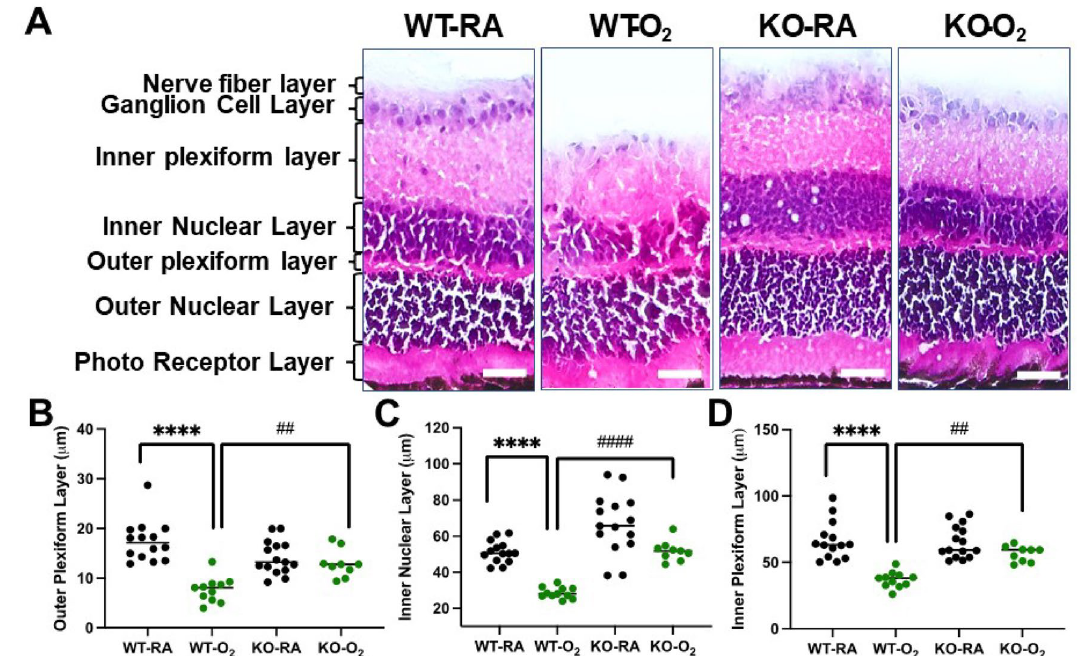
Figure 8. GSDMD-KO prevents hyperoxia-induced retinal thinning. ( A ) The thickness of the individual retinal layer was assessed on H&E stained eye sections. Hyperoxia exposure reduced the thicknesses of the outer plexiform layer, inner plexiform layer, and inner nuclear layer in WT mice. However, GSDMD-KO mice had overall decreased retinal thinning in these three layers compared to the WT hyperoxic group. ( B ) Outer plexiform layer: **** P < 0.0001, WT-RA vs WT-O 2 , ## P < 0.01, WT-O 2 vs KO-O 2. C. Inner plexiform layer: **** P < 0.0001, WT-RA vs WT-O 2 , #### P < 0.01, WT-O 2 vs KO-O 2 . ( D ) Inner nuclear layer: **** P < 0.0001, WT-RA vs WT-O 2 . ## P < 0.01, WT-O 2 vs KO-O 2. n = 9–15/group. 20 × magnification. Scale bars: 50 effects of GSDMD-KO and identify genes modulated by GSDMD-KO on hyperoxia-induced retinal injury, we performed RNA-seq of whole retinas. Principal component analysis of the retina transcriptome showed cluster- ing of hyperoxia-exposed GSDMD-KO and WT animals (Fig. 10A). To identify similarities and divergencies in genes differentially regulated by hyperoxia in the WT and GSDMD-KO animals, differential expression analysis was performed comparing RA-exposed WT vs hyperoxia-exposed WT retinas and RA-exposed GSDMD-KO vs hyperoxia-exposed GSDMD-KO retinas, and the results were analyzed at the gene expression and pathway levels (Fig. 10B). In WT retinas hyperoxia differentially regulated 1224 genes, and in GSDMD-KO retinas, hyperoxia differentially regulated 1360 genes. There were 480 genes commonly induced or suppressed by hyperoxia in both WT and GSDMD-KO retinas, 738 genes uniquely regulated in WT retinas, and 873 genes uniquely regulated in GSDMD-KO retinas (Fig. 10C). Overrepresentation analysis of genes differentially regulated by hyperoxia in WT and GSDMD-KO retinas showed that in WT retinas, genes induced by hyperoxia were strongly associated with mitotic cell cycle, cellular division, blood vessel diameter maintenance, positive regulation of NF-κB tran- scription, fibroblast proliferation, vasoconstriction, C–C chemokine receptor activity, and VEGF and VEGFR signaling network (Fig. 10D). In GSDMD-KO retinas, hyperoxia suppressed genes were more uniquely asso- ciated with retinol binding, neurofilament bundle assembly, diseases associated with visual transduction and neuroactive ligand-receptor interaction (Fig. 10D). We performed qRT-PCR to validate some of the differentially regulated genes by hyperoxia in the WT and GSDMD-KO retinas. Hyperoxia upregulated gene expression of baculoviral IAP Repeat Containing 3 ( Birc3 ) (Fig. 10E), Birc5 (Fig. 10F), Edn2 (Fig. 10G), NLR family CARD-containing 3 ( Nlrc3 ) (Fig. 10H), platelet-derived growth factor receptor beta ( Pdgfrb ) (Fig. 10I), and signal transducer and activator of transcription 3 ( Stat3 ) (Fig. 10J) in the WT retinas. However, these genes were downregulated in hyperoxia-exposed GSDMD KO retinas compared to hyperoxic WT retinas. Cluster comparison of analysis using ClusterProfiler showed that genes induced by hyperoxia were associated with chemokine receptor activity, transforming growth factor beta (TGF-β) activated receptor activity, death receptor activity, complement receptor activity, and TNF receptor superfamily binding in WT animals but not in KO animals. Genes suppressed by hyperoxia were associated with glutamate binding, amino acid binding, gap junction channel activity, and cell adhesion mediator activity in WT but not in GSDMD-KO retinas (Supplemen- tal Fig. 4). In GSDMD-KO retinas, hyperoxia upregulated gene pathways were associated with immunoglobulin binding, extracellular matrix structural constituent, growth factor activity, and mitogen-activated protein kinase binding. Hyperoxia downregulated gene pathways were associated with oxygen binding, dopamine receptor binding, and photoreceptor activity. Direct comparison of hyperoxia-exposed GSDMD-KO mice to hyperoxia- exposed WT mice revealed 1224 differentially regulated genes with 841 induced genes and 383 suppressed genes